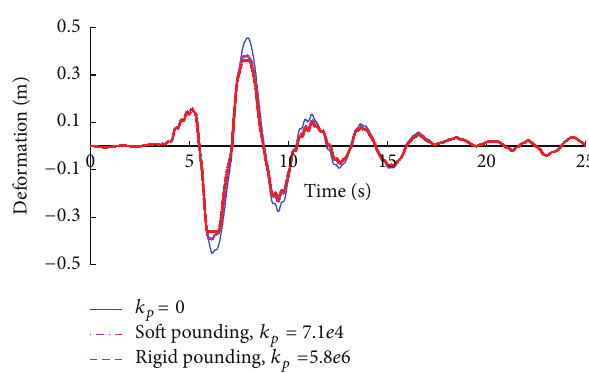
Figure 15: Comparison of the deformation history-time cure of the isolation layer with different pounding